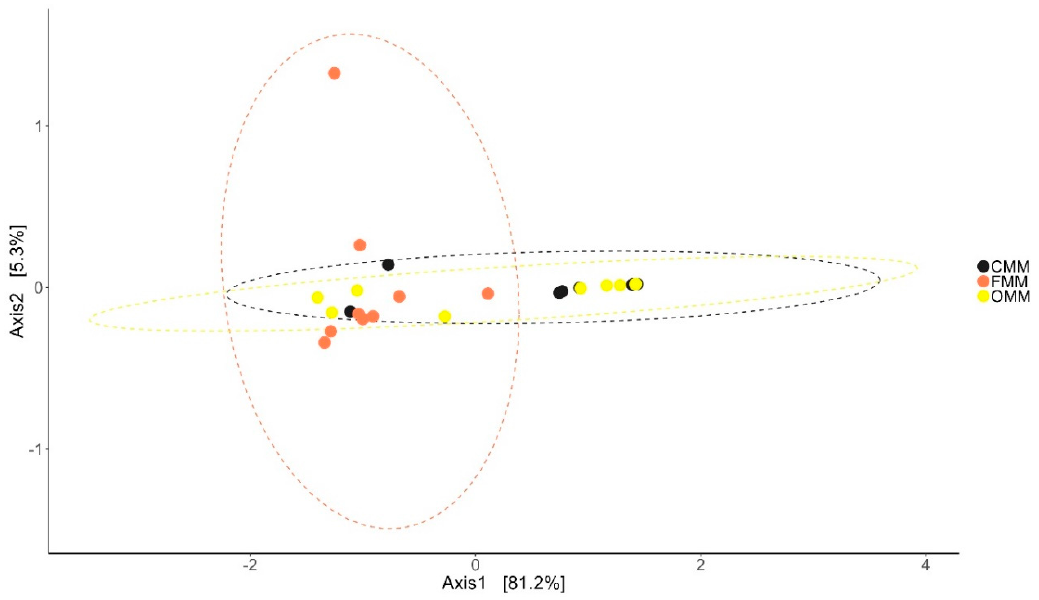
Figure 2. Differences in the beta diversity of the bacterial communities present in the mid intestine mucus of Atlantic salmon. The data in the ellipse-enclosed areas come from a multivariate normal distribution. The codes for the mucus samples are as follows: control group, CMM; florfenicol-fed group, FMM; oxolinic-acid-fed group, OMM.